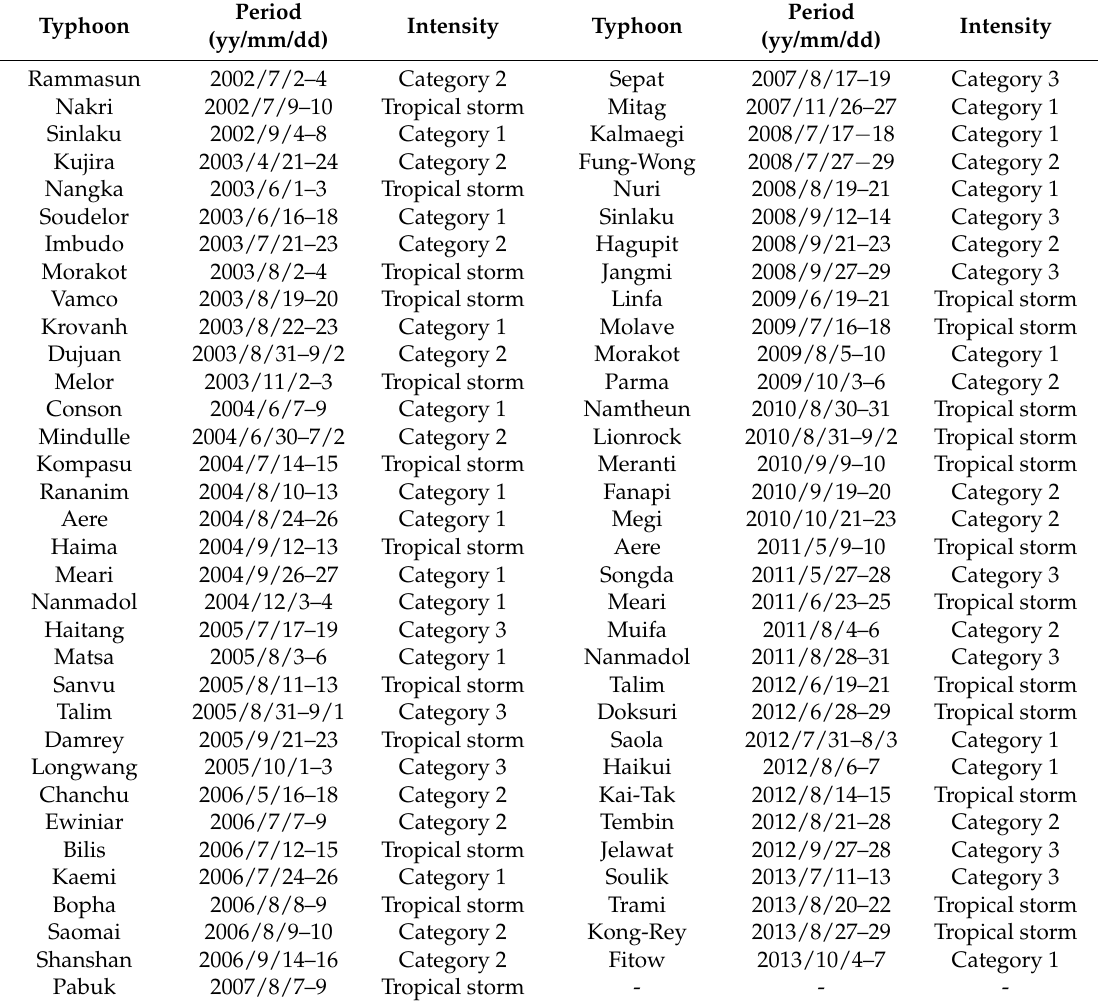
Table A1. Typhoons affecting offshore northeast Taiwan and typhoon intensity